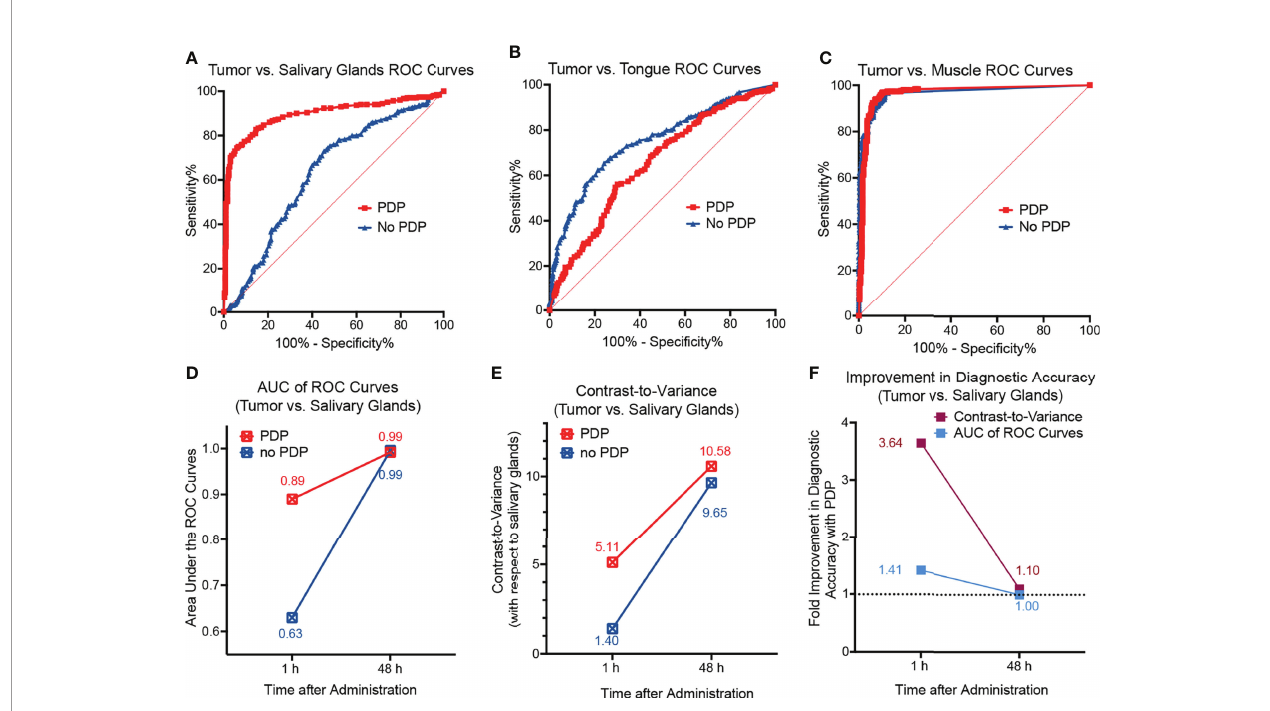
FIGURE 5 | Receiver operating characteristic (ROC) curves of tumors with respect to (A) salivary glands, (B) the tongue, and (C) healthy muscle tissue from the hind leg of mice 1 h after administration of Cet-IRDye800 with and without PDP. (D) The diagnostic accuracy with respect to salivary glands as depicted by the AUC analyses of the ROC curves suggests that PDP increases the diagnostic accuracy at 1 h after administration. (E) The diagnostic accuracy with respect to salivary glands as depicted by the measure of contrast-to-variance suggests that PDP increases the diagnostic accuracy at both 1 h and 48 h after administration. (F) The percentage improvement of the diagnostic accuracy with respect to salivary glands with PDP at both 1 h and 48 h after